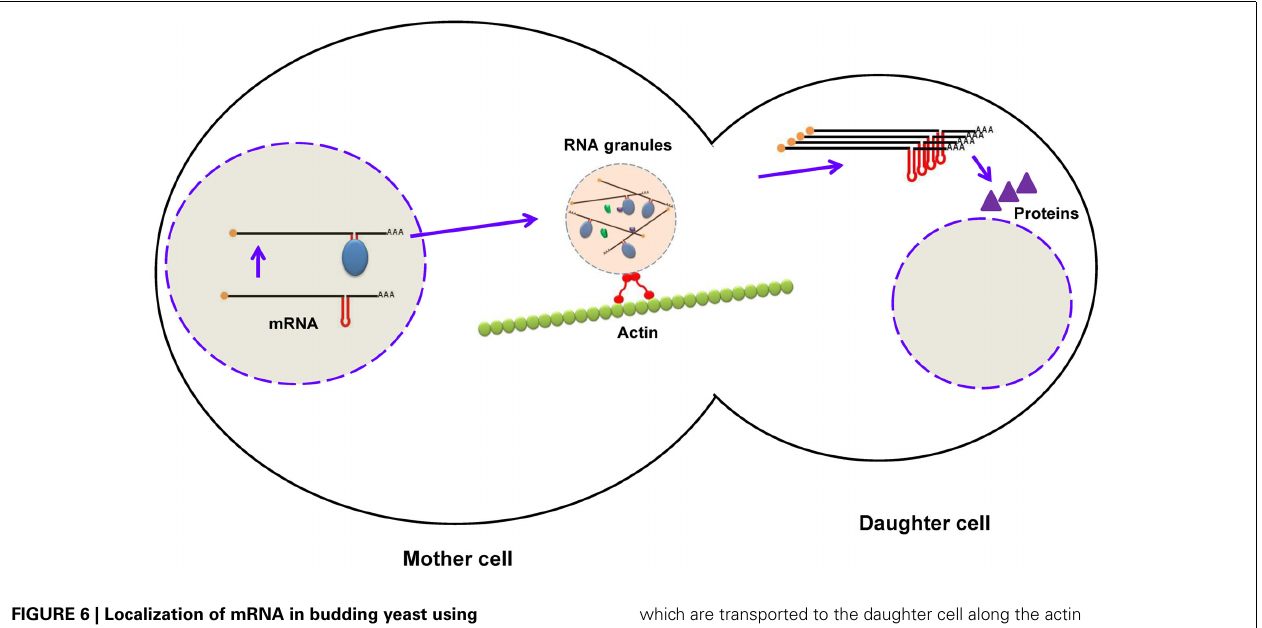
FIGURE 6 | Localization of mRNA in budding yeast using zipcodes. During maturation of mRNA (ASH1), RNA-binding proteins bind to zipcodes and form ribonucleoprotein complexes. After export to the cytoplasm, some proteins are added to form RNA granules,